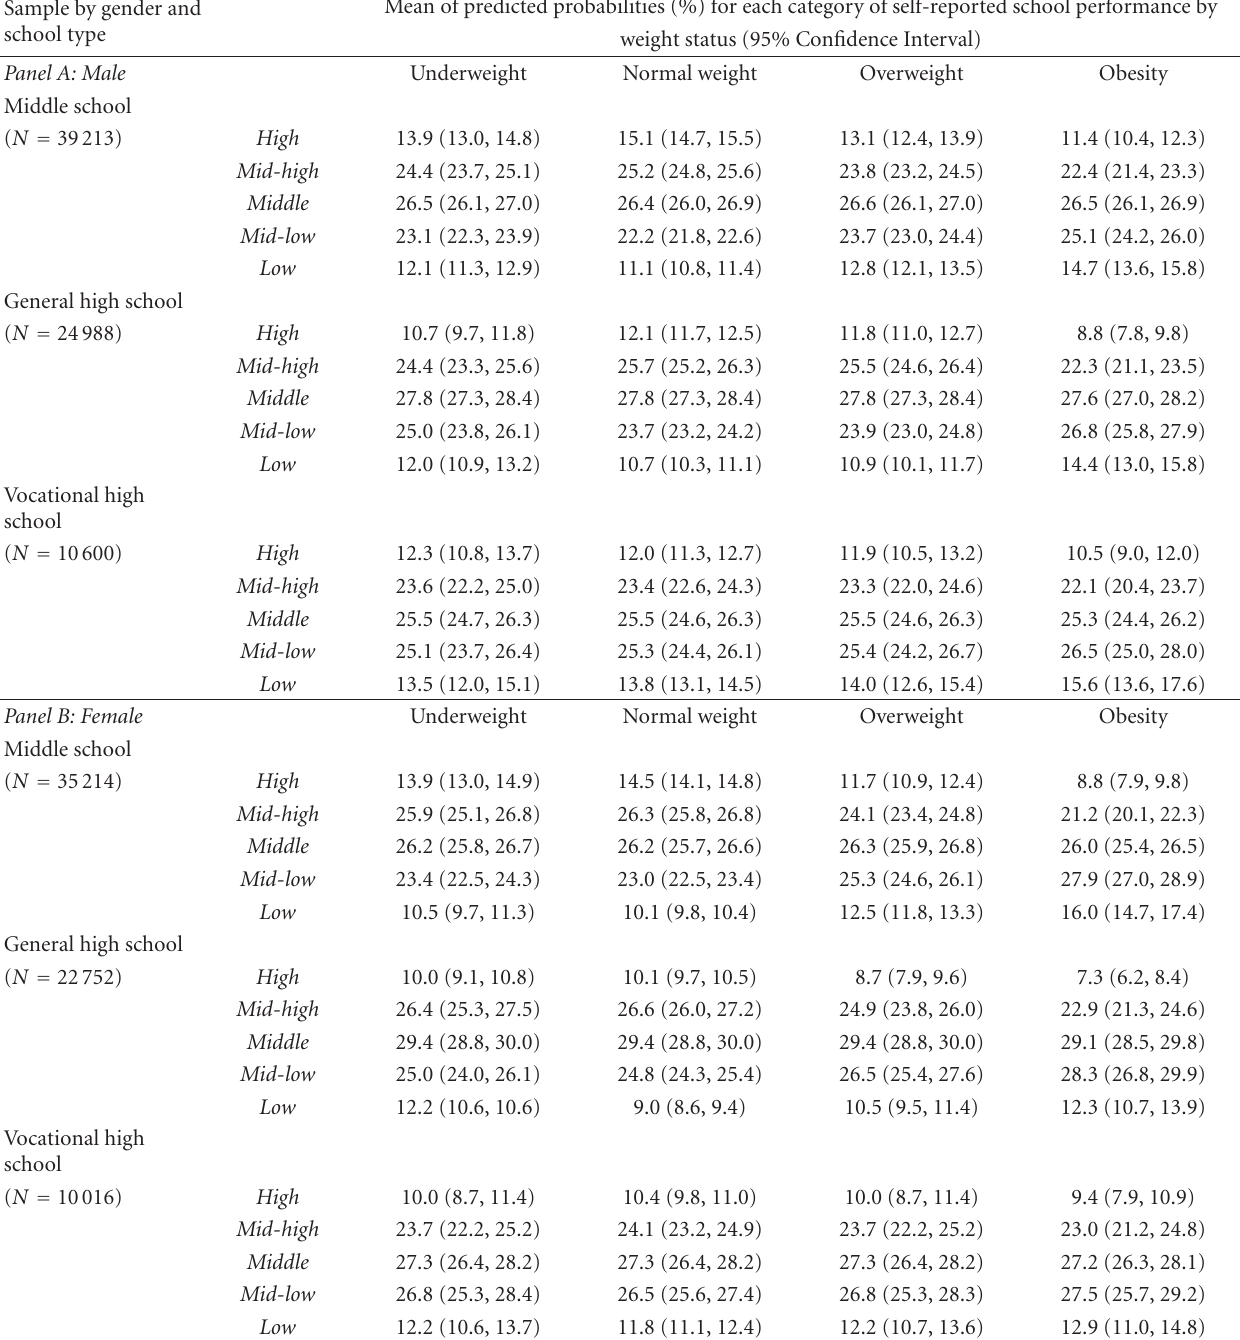
Table 2: Predicted probabilities for self-reported school performance categories by weight